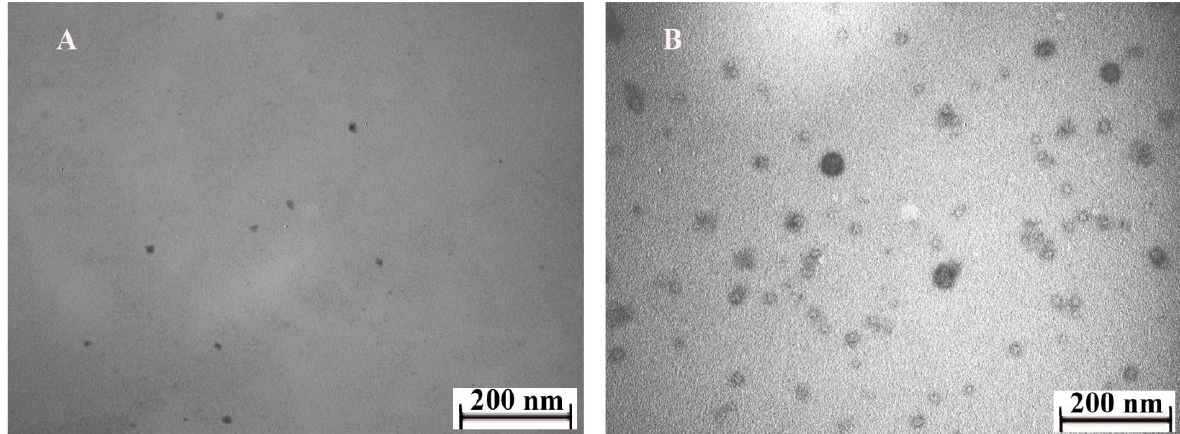
Figure 2. Microphotographs of Se/AG NC ( A ) and Se/ST NC ( B ) taken with a transmission electron microscope (TEM).